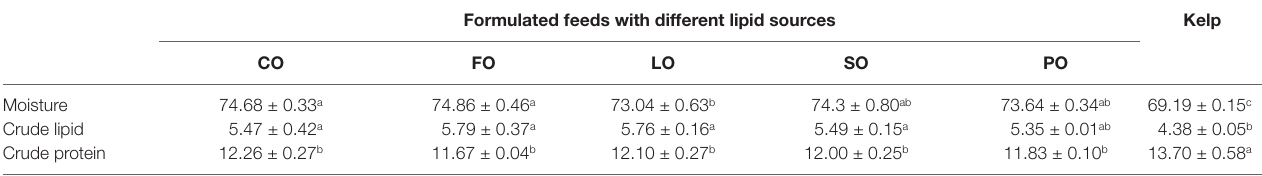
TABLE 7 | Effects of different lipid sources on the proximate composition (% wet weight) in the ovary of adult sea urchin ( Strongylocentrotus intermedius ) (mean ± SEM, n=3) 1 . Formulated feeds with different lipid sources